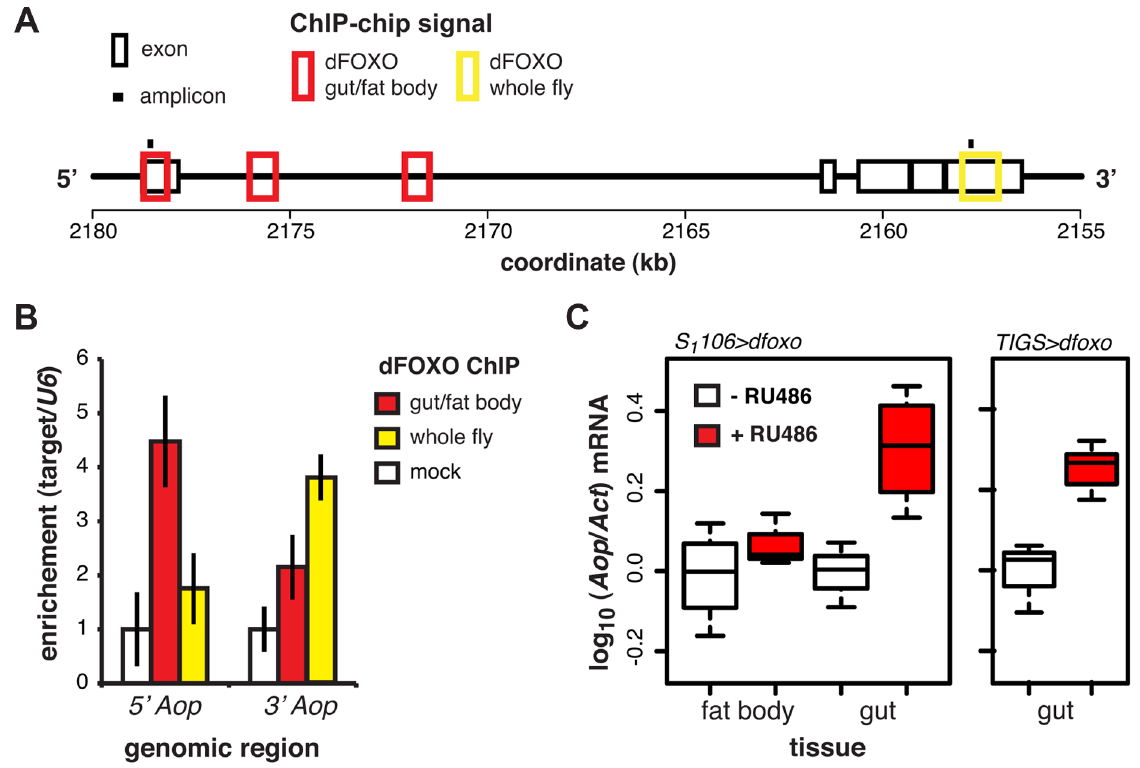
Figure 3. dFOXO regulates expression of Aop in the adult gut. A Schematic of the Aop locus with black boxes representing exons, red boxes – regions detected as bound by GFP-dFOXO in the ChIP-chip experiment on induced S 1 106 . GFP-dfoxo females (dFOXO gut/fat body), yellow box - region detected as bound by dFOXO in wild-type females (dFOXO whole fly, data obtained from reference [17]), and black bars – position of amplicons used for qPCR in B. B The enrichment of 5 9 or 3 9 end of the Aop locus, relative to U6 , after anti-GFP IP of chromatin from RU486-induced S 1 106 . dfoxo females (mock), anti-GFP IP of chromatin from RU486-induced S 1 106 . GFP-dfoxo females (gut/fat body) or anti-dFOXO IP of wild-type female chromatin (whole fly). Means 6 SEM of three biological repeats are shown, with enrichment in the mock control set to one. ANOVA on log- transformed data detected significant differences (p=0.03 per region) and the enrichment of the 5 9 region was different in gut/fat body from the mock (one-tailed t-test, p=6 6 10 2 3 ), while the 3 9 region was enriched in the whole fly (one-tailed t-test, p=5 6 10 2 3 ). C Aop mRNA was quantified relative to Act by qPCR in guts or fat bodies of S 1 106 . dfoxo , or TIGS . dfoxo flies induced or not with RU486. Boxplots show log-10 derived relative expression with - RU486 values set to zero. Data for S 1 106 . dfoxo females were analysed with a mixed-effects linear model with dissection batch as a random effect. The effects of RU486, tissue and their interaction was significant (p , 0.05) and RU486 caused significant up-regulation of Aop in the gut (one-tailed t-test, n=3–4, p=2 6 10 2 3 ) but not the fat body (one-tailed t-test, n=4, p . 0.05). Significant changes were observed in TIGS . dfoxo guts (t-test, n . 3, p=0.02).